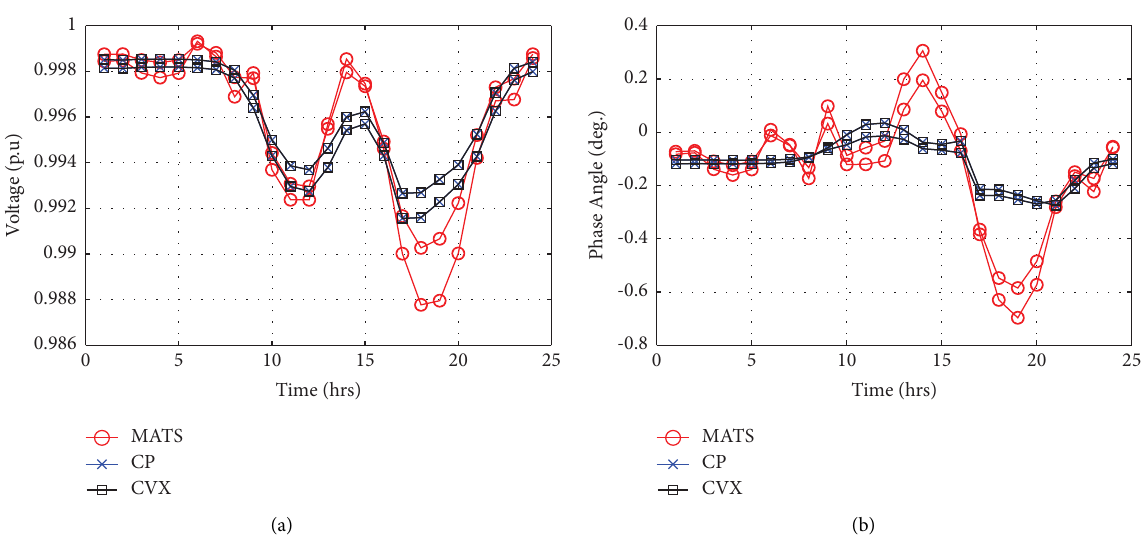
Figure 6: Voltage magnitude (a) and phase (b) plot for simulation